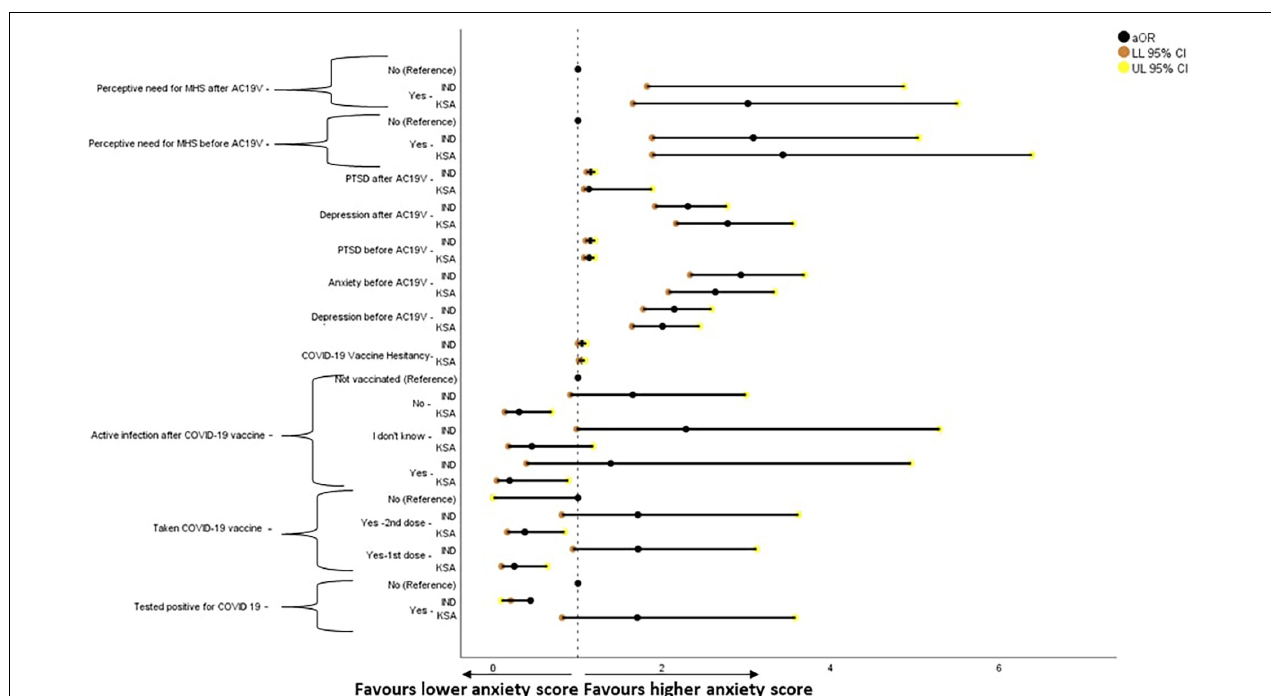
FIGURE 6 | Forest plot showing adjusted binary logistic regression analysis of anxiety scores (REGRESSION model 2). aOR, adjusted Odds Ratio; Odds ratio adjusted for Sociodemographic factors. 95% CI, 95% Confidence Interval. The results of regression model 1, 2, and 3 in binary logistic regression analysis of depression scores is tabulated in Supplementary Table 13 . Ind–India; KSA–Kingdom of Saudi